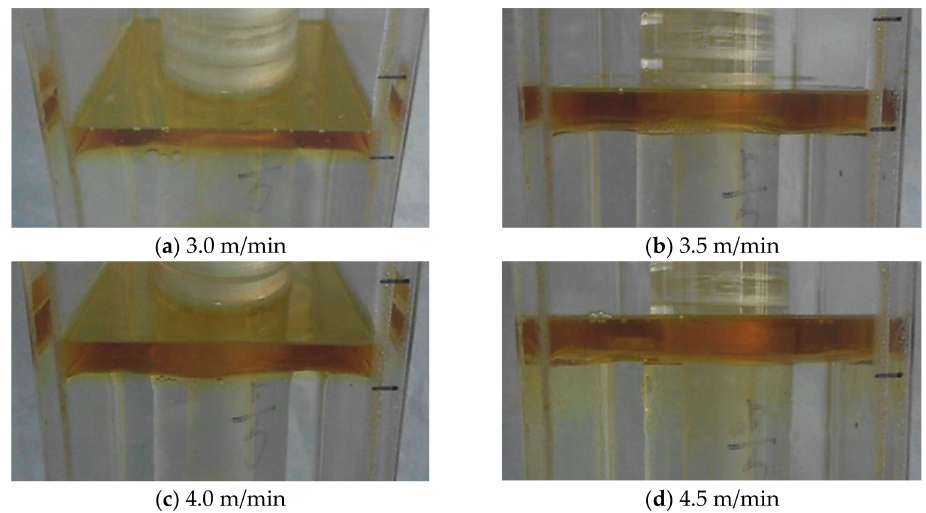
Figure 12. Comparison of numerical simulation and physical simulation of mold liquid surface flow under high casting